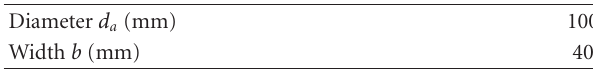
Table 2: Geometrical properties of the